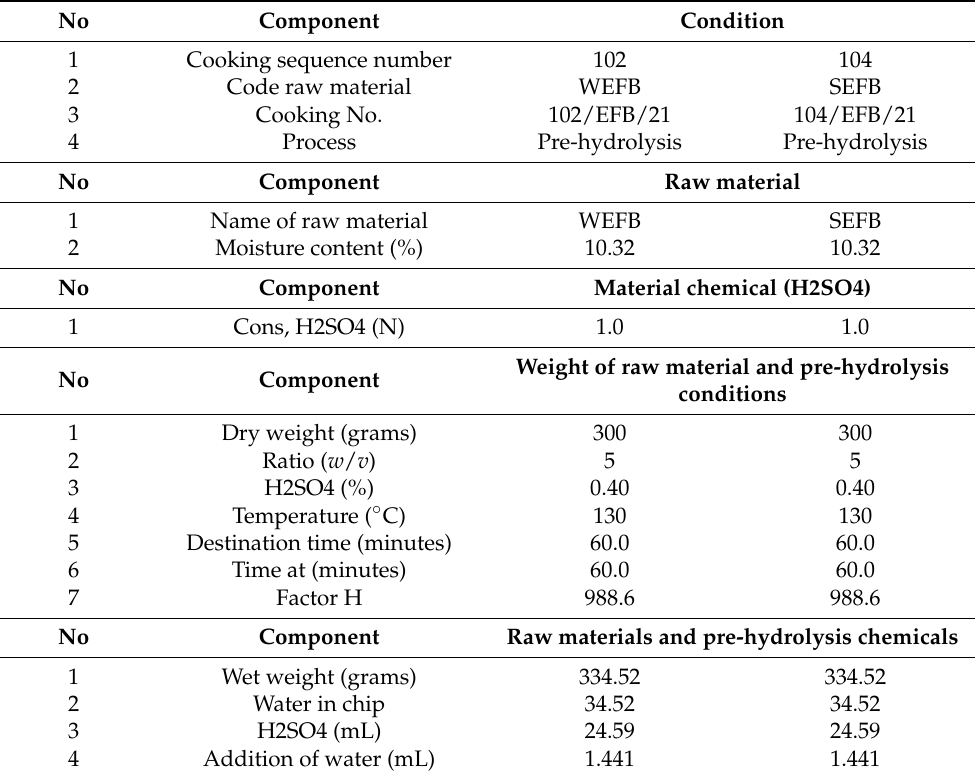
Figure 4. ( a ). EFB fiber (first sample and second sample) with a length of 2–3 cm and a mass of 300 g was inserted into the rotary digester tube ( b ). Addition of 1 N sulfuric acid, 0.4% sulfate pre-hydrolysis with a ratio of 1:5 ( w / v ); ( c ). EFB fiber was cooked at 130 °C for 60 min (time to reach maximum temperature was 60 min and held for 90 min). Table 1. Raw materials and pre-hydrolysis process conditions for whole-empty fruit bunches (WEFB) and stalk-empty fruit bunches (SEFB).